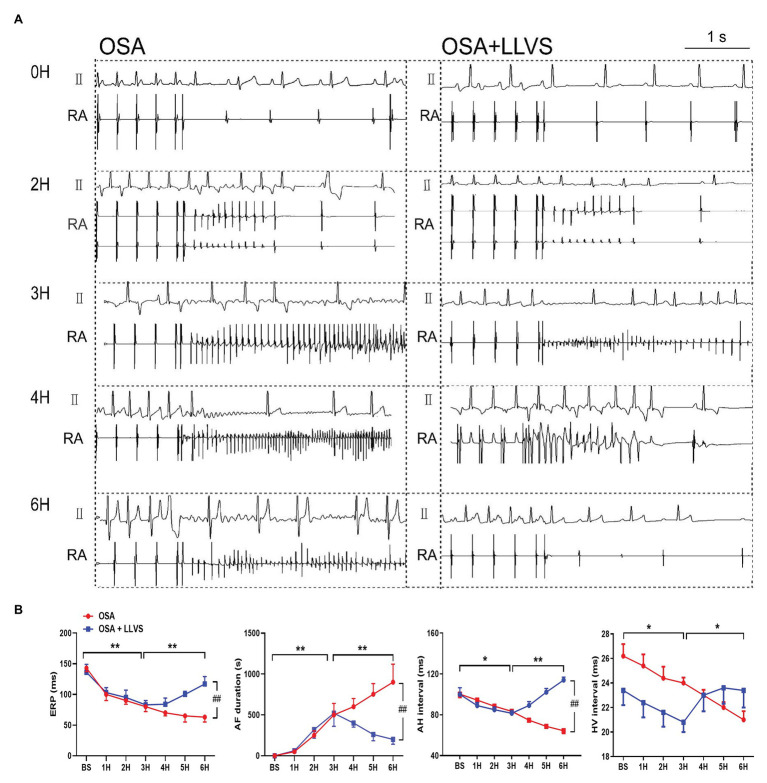
(A) Representative examples of AF episodes in the OSA and OSA+LLVS groups at baseline, the 2nd hour, the 3rd hour, the 4th hour, and the 6th hour. (B) Changes in ERP, AF duration, AH interval, and HV interval at each hour among the three groups. *p<0.05, **p<0.01, ##p<0.05; ERP, effective refractory period; AF, atrial fibrillation; AH, Atrial-His; HV, His-Ventricle; H, hours.